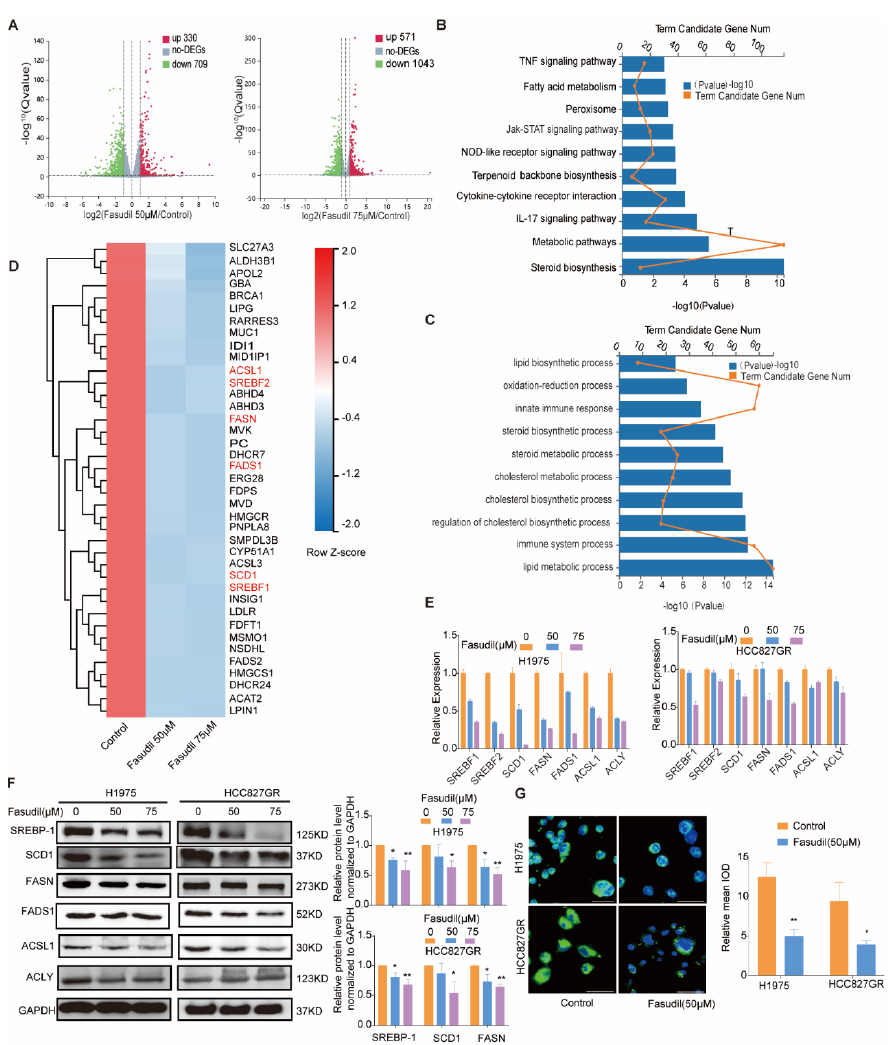
Figure 3. Changes in the gene ‐ expression profile of Fasudil ‐ treated H1975 cells. ( A ) Volcano plot showing the distribution of ‐ log10 (FDR) vs. log2 (Fold Change). The red points indicate upregula ‐ tion ( p < 0.05) and green points indicate downregulation ( p < 0.05), while the gray points indicate P ≥ 0.05. ( B ) KEGG pathway ‐ enrichment analysis for Fasudil ‐ induced downregulated genes. ( C ) GO pathway ‐ enrichment analysis results. ( D ) Heatmap of the expression levels of lipid ‐ metabolism ‐ associated genes (Z scores were used). The red and green areas indicate high and low expression levels, respectively. ( E ) RT ‐ qPCR validation of the downregulation of lipid ‐ metabolism ‐ associated genes (SREBF ‐ 1, SREBF ‐ 2, SCD1, FASN, FADS1, ACSL1, and ACLY) in H1975 cells after Fasudil treatment. All values are expressed as the mean ± SD ( n = 3). * p < 0.05 and ** p < 0.01. ( F ) Western blot analysis of SREBP ‐ 1, SCD1, FASN, FADS1, ACSL1, and ACLY expression in HCC827/GR and H1975 cells treated with Fasudil (50, 75 μ M) for 48 h. ( G ) H1975 and HCC827/GR cells were stained with BODIPY 493/503 (green) and counterstained with DAPI (blue) after 48 h of exposure to Control (ddH2O) or Fasudil (50 μ M). Lipid accumulation of indicated cell lines was evaluated by measuring green fluorescence by Image J. The uncropped blots are shown in Supplementary File S1.